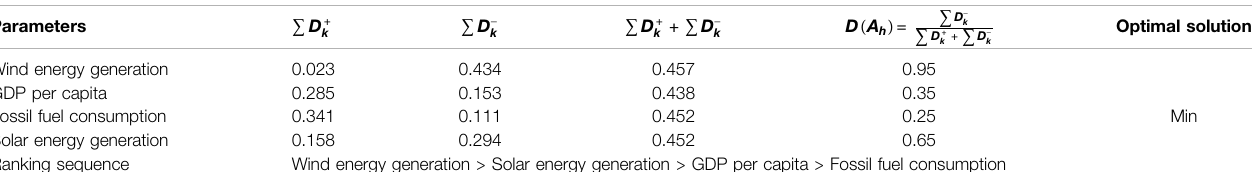
TABLE 8 | Estimated grey degree of synthetic assessment. Parameters (cid:25) D +